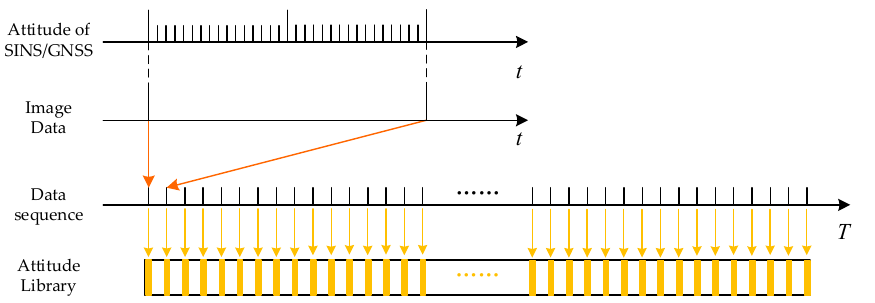
Figure 2. The working sequence of the off-line attitude library construction method. The liner system of SINS/GNSS can be expressed as: